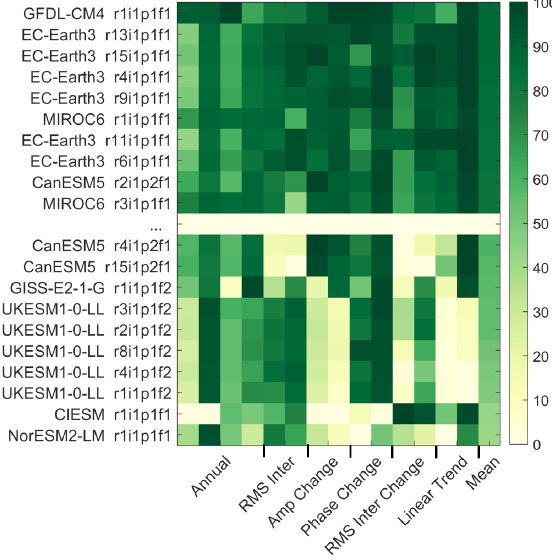
Figure 12. Ranking of the ensemble members according to the classes assigned with pattern correlation (odd columns) and RMSD of ECDF (even columns) of annual cycle and interannual RMS with GRACE (colums 1–6) and amplitude change, phase change, interannual RMS change and linear trend with the MMMed (columds 7–14). Mean rank given in column 15. The upper 10 ensemble members are the best performing, the lower 10 the worst. The full ranking table is provided in the Supplementary Material, Figure